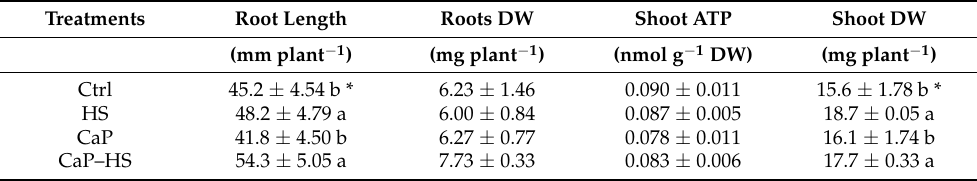
Table 3. Seedling root length, root and shoot dry weight, and ATP concentration in shoots of Valerianella locusta . Data are expressed as mean ± standard deviation (n = 4). Different letters indicate statistically significant difference between treatments at Tukey’s post-hoc test ( p ≤